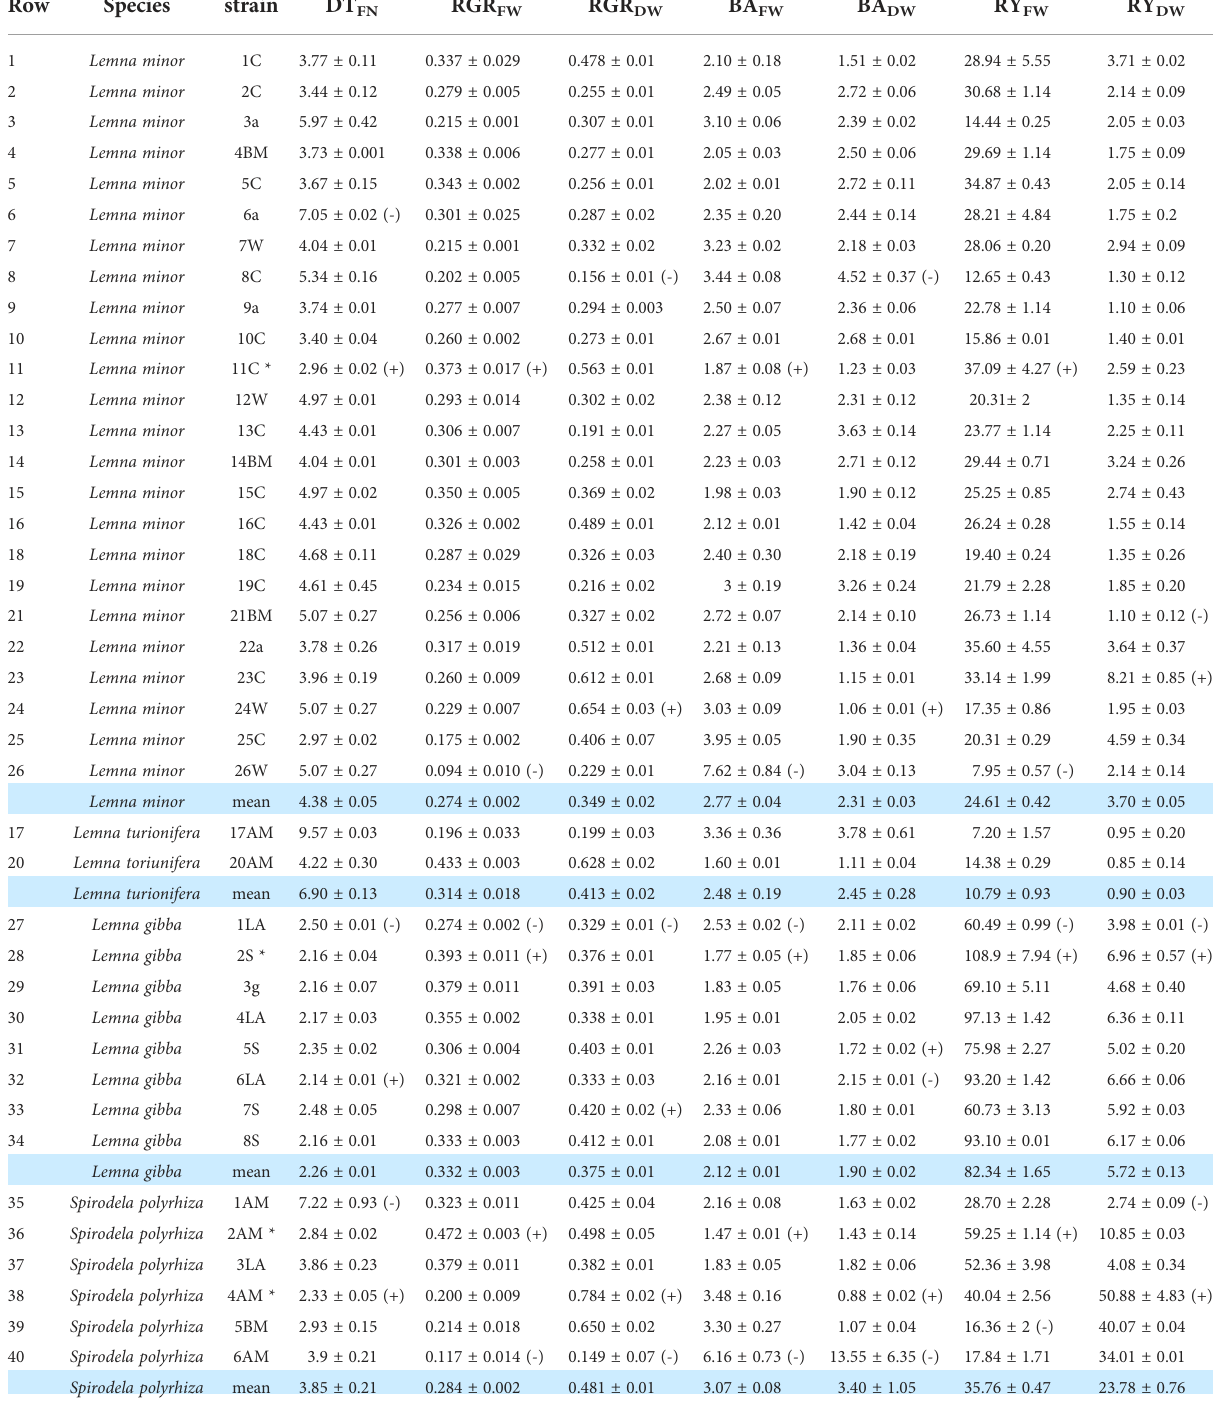
TABLE 4 Fresh and dry weight biomass accumulation and doubling time of 40 geographical isolates of native Iranian duckweed representing four